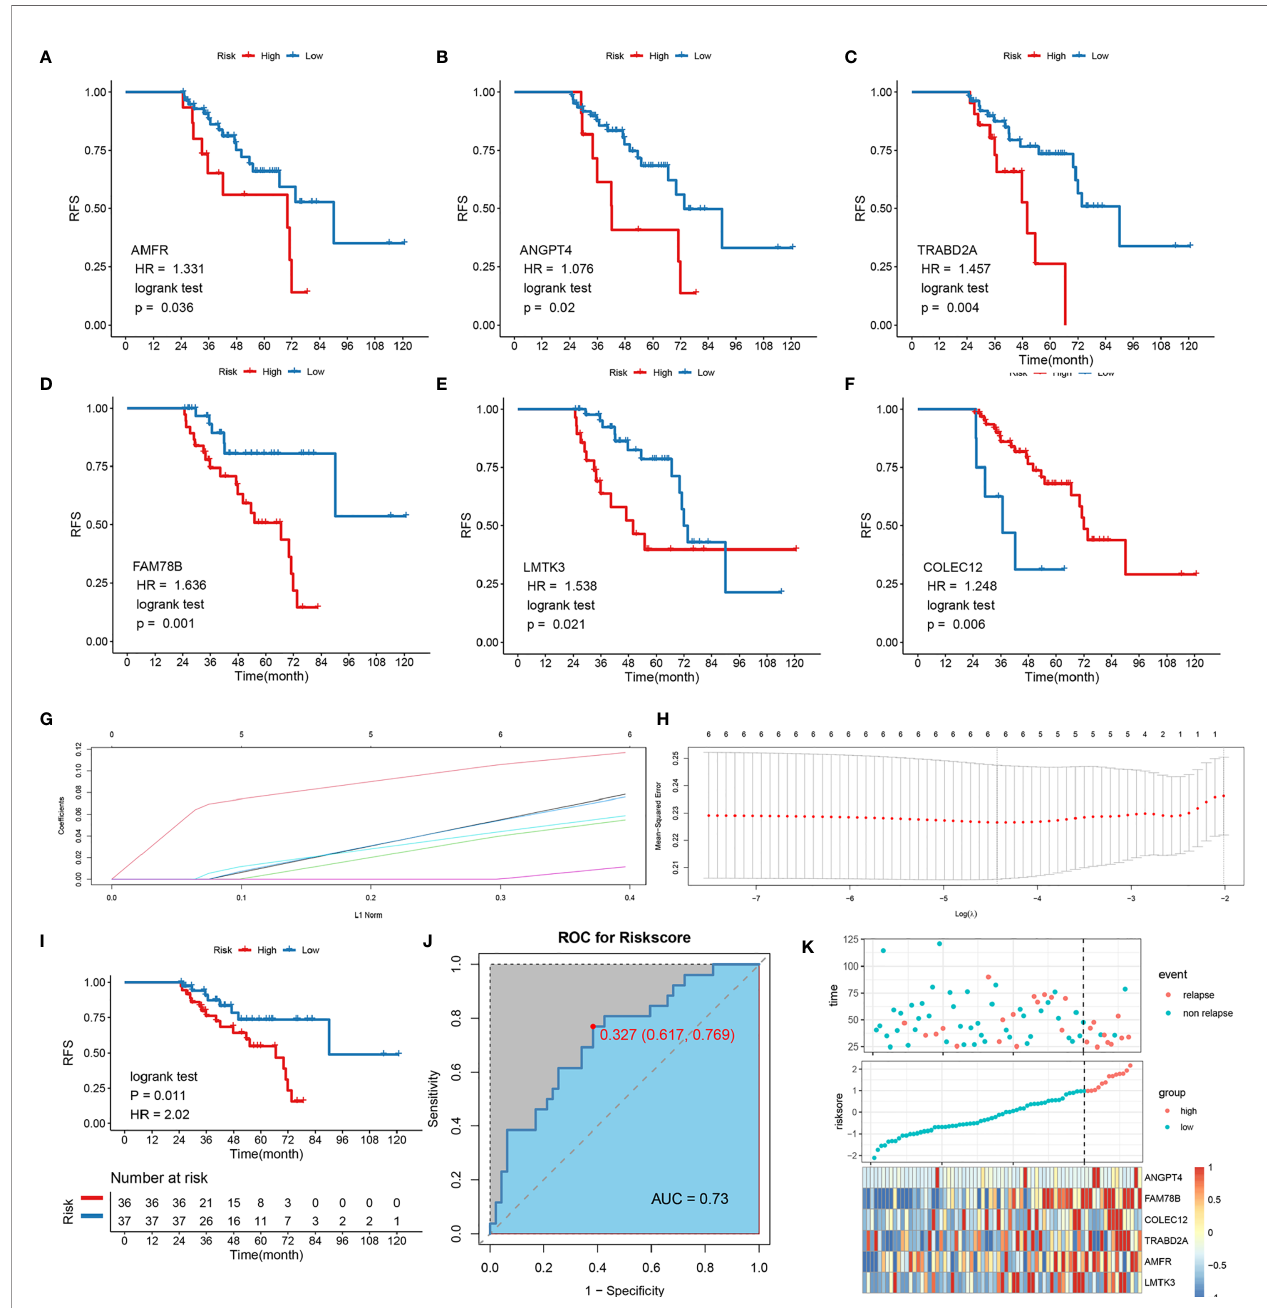
FIGURE 2 | Survival analysis of the six SLRGs and development of the LR-related signature in the TCGA-LIHC cohort. (A – F) The Kaplan – Meier analysis of the six SLRGs. The six SLRGs were ANGPT4 , AMFR , COLEC12 , FAM78B , LMTK3 , and TRABD2A . (G , H) The results of the LASSO regression. (I) Kaplan – Meier analysis. (J) The ROC curve of the model. (K) The distribution of risk score, recurrence status, and gene expression